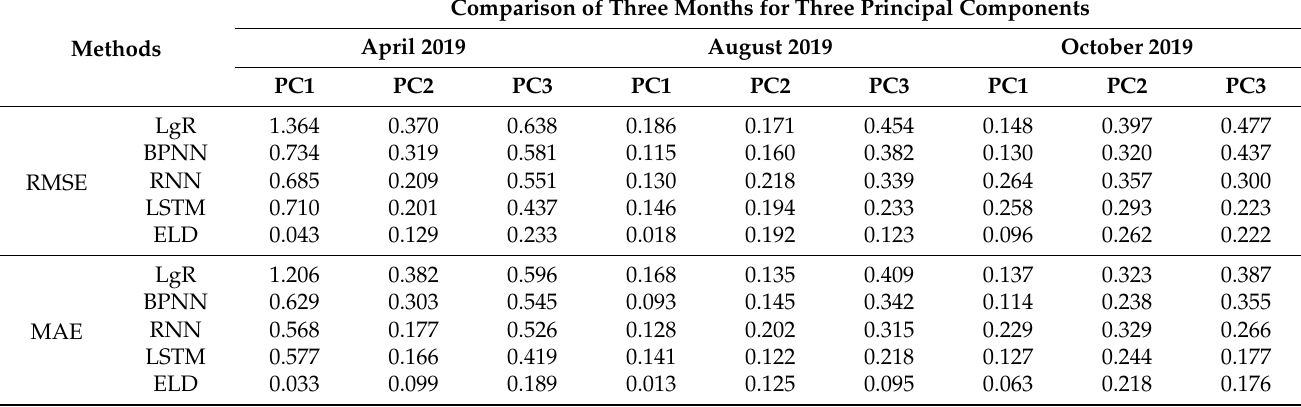
Table 1. Comparison of forecasting capabilities of multiple models in test datasets